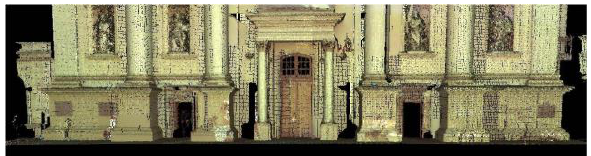
Figure 1. Point cloud representing the measured object after